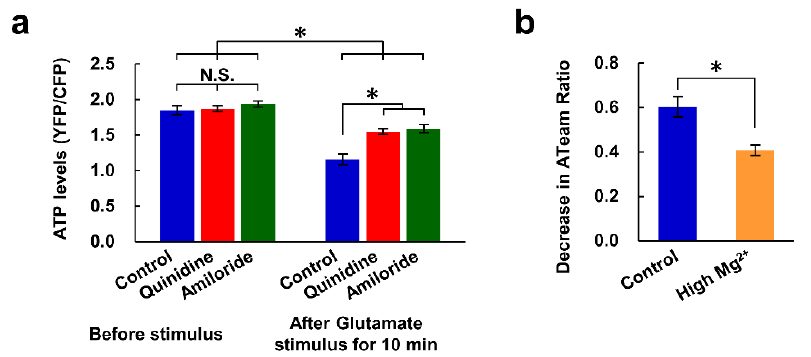
Figure 5. Inhibitors of Mg 2+ extrusion attenuated the glutamate-induced decrease in intracellular ATP level. ( a ) Comparison of intracellular ATP levels (YFP/CFP ratio of ATeam) before and 10 min after application of the glutamate stimulus in the presence or absence of inhibitor ( n = 10, 16, 18 cells from 6 replicates for each). Error bars indicate SEM. * indicates P < 0.05 among all possible combinations by Tukey’s test. N.S. indicates no statistically significant difference. ( b ) Comparison of decrease in ATeam ratio induced by glutamate stimulus in 10 min under control and high Mg 2+ (8 mM) conditions (control: n = 32 cells from 9 replicates; High Mg 2+ : n = 34 cells from 11 replicates). Error bars indicate SEM. * indicates P < 0.05 by t-test.